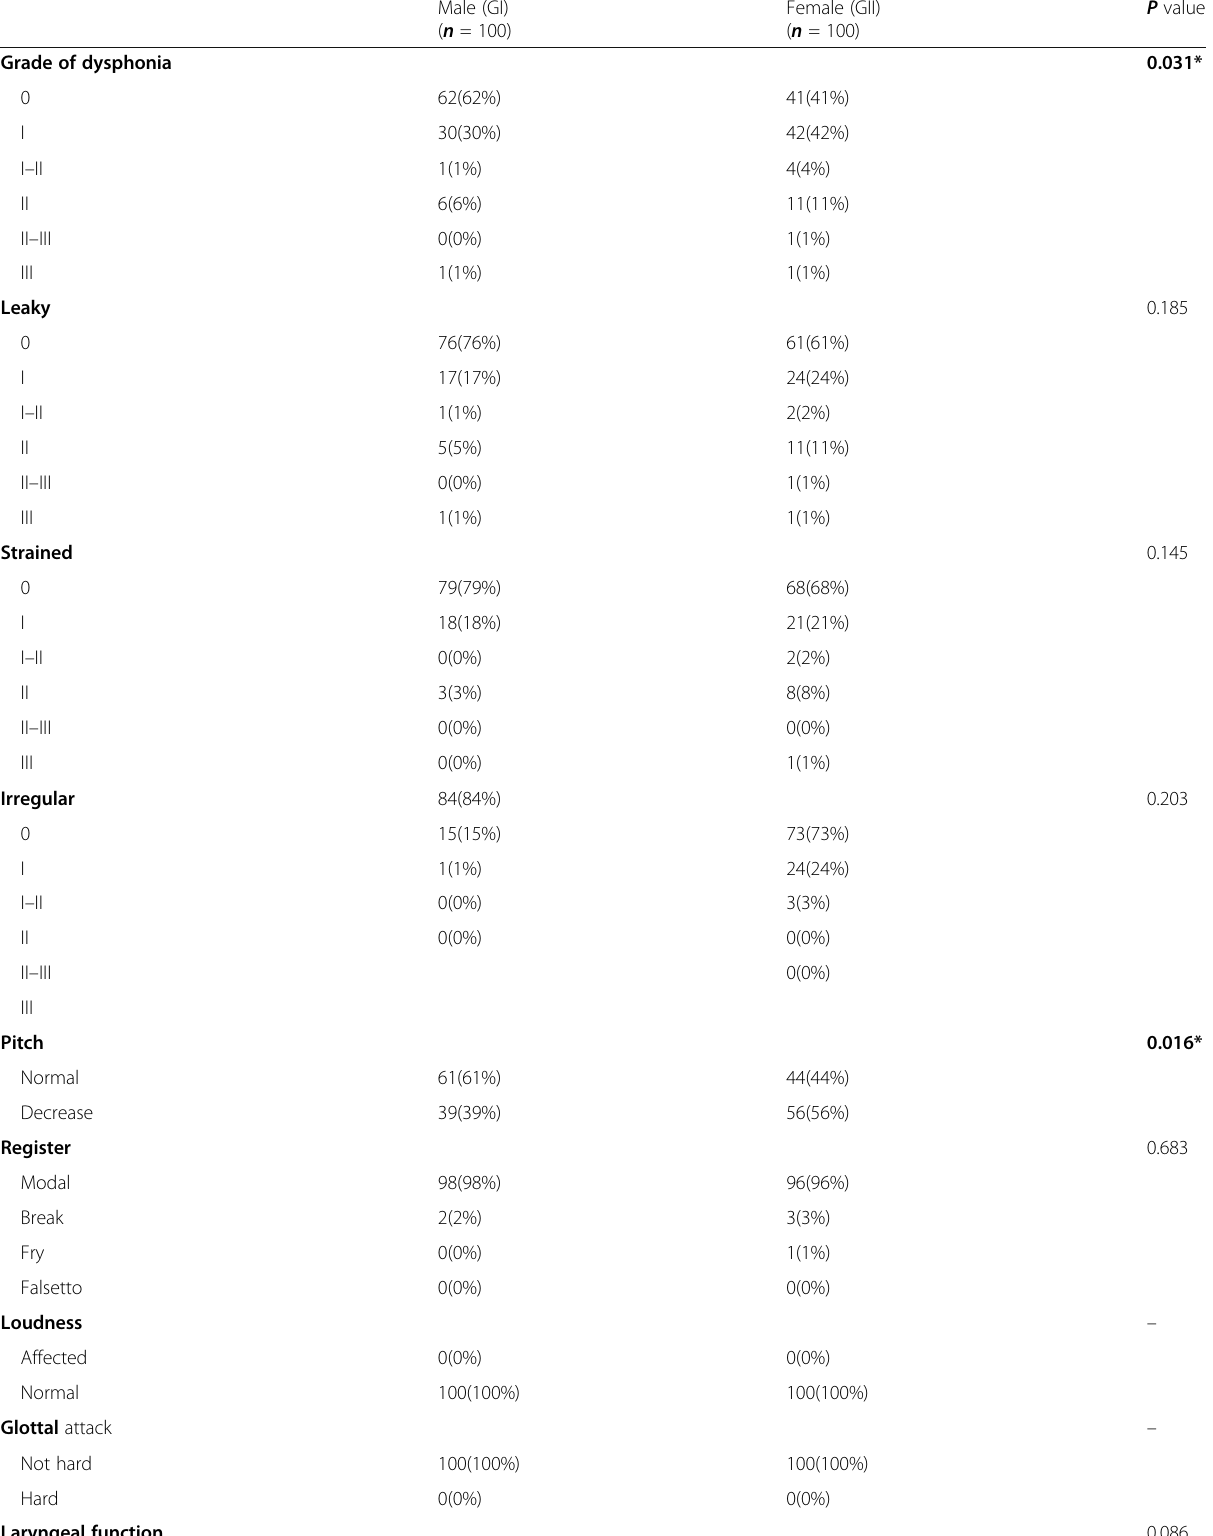
Table 7 Comparison between male and female teachers in Auditory Perceptual